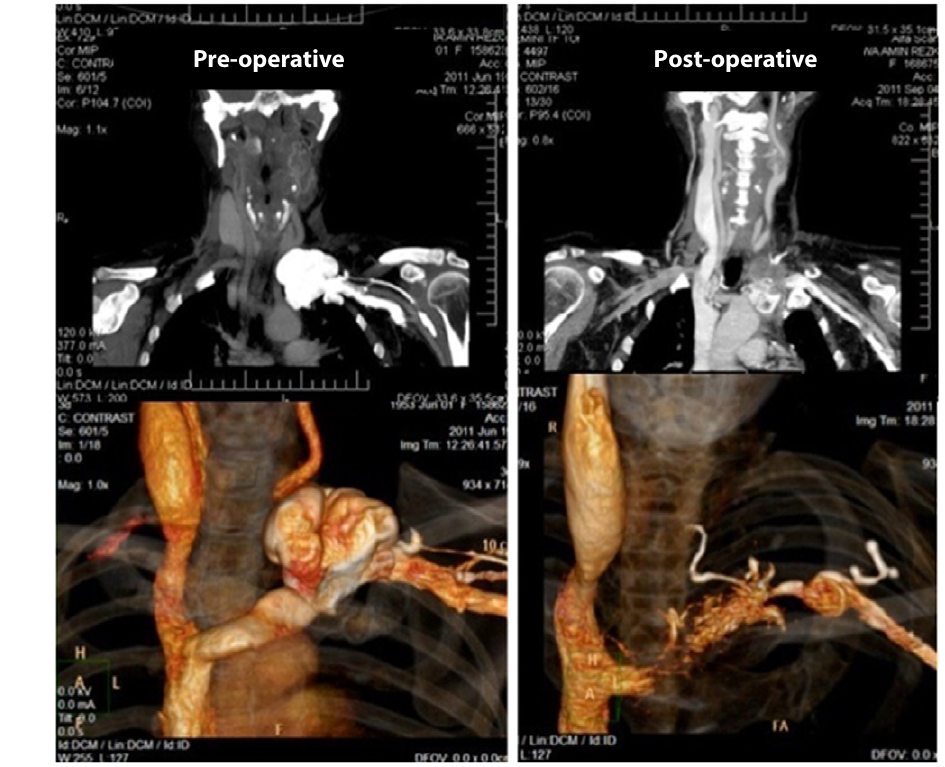
Figure 1. Contrast enhanced CT study (venous phase) with coronal and reconstructed pre- and post-operative images.Pre-operatively:aneurysmallydilatedvenoussacconnectedtotheleftsubclavianvein.Theleftinternal jugular vein is not visualized whilst the right is significantly dilated; post-operatively: total thrombosis of the aneurysm with apparent attenuation of the left subclavian vein in the coronal